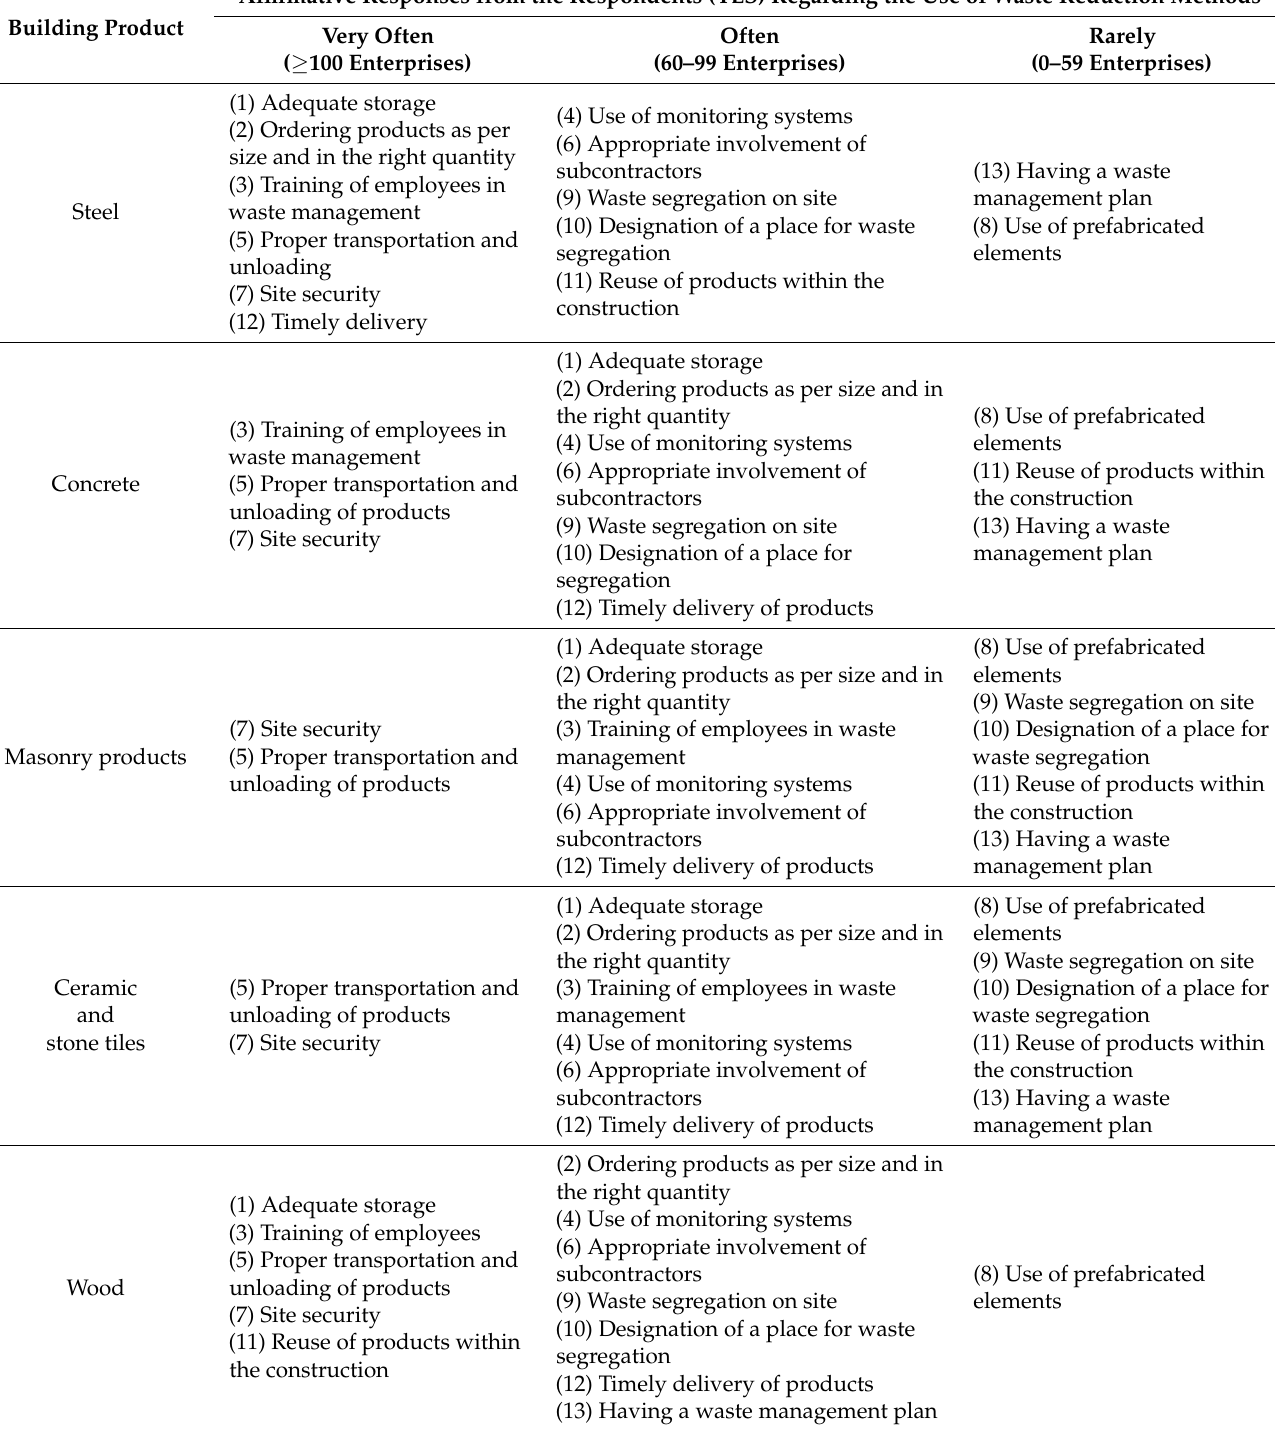
Classification of waste reduction methods in terms of their frequency of use in construction